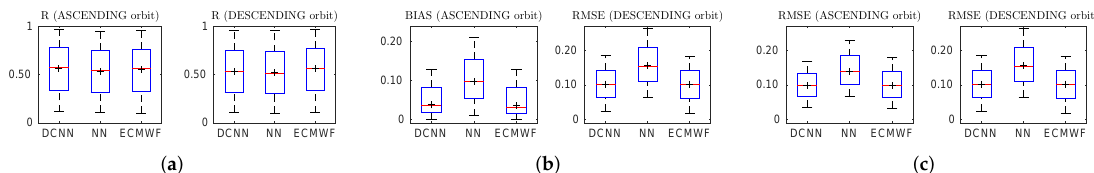
Figure 5. Box plots for ( a ) Pearson correlation coefficient, ( b ) BIAS and ( c ) RMSE between DCNN SM/NN SM/ERA-Interim SM time series and the in situ measurements. The blue boxes contain the middle 50% of the data, and the red line represents the median value of the distribution. The upper edge of the box indicates the 75th percentile of the data (Q3), and the lower edge indicates the 25th percentile (Q1). The mean values are also shown as black crosses. The upper and lower bars represent the minimum and maximum values of the distribution excluding outliers. Points are considered as outliers if they are larger than Q3 + 1.5 × IQR or smaller than Q1 − 1.5 × IQR, where inter quartile range (IQR) means Q3 − Q1.